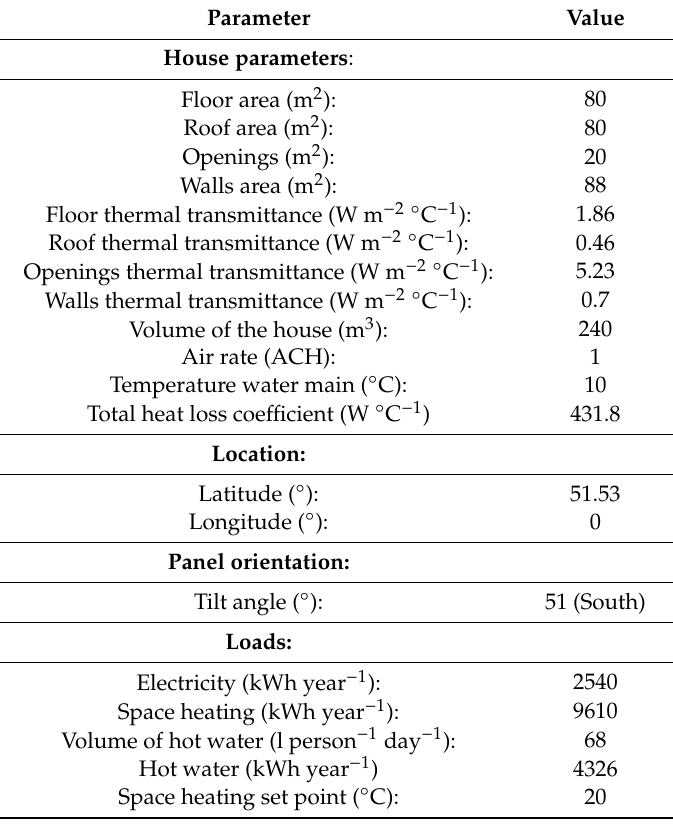
Table 1. Building loads and solar parameters and